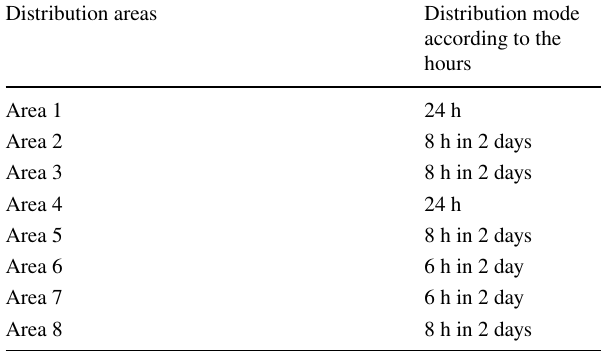
Table 1 Hours of distribution of each area of the city Distribution areas Distribution mode